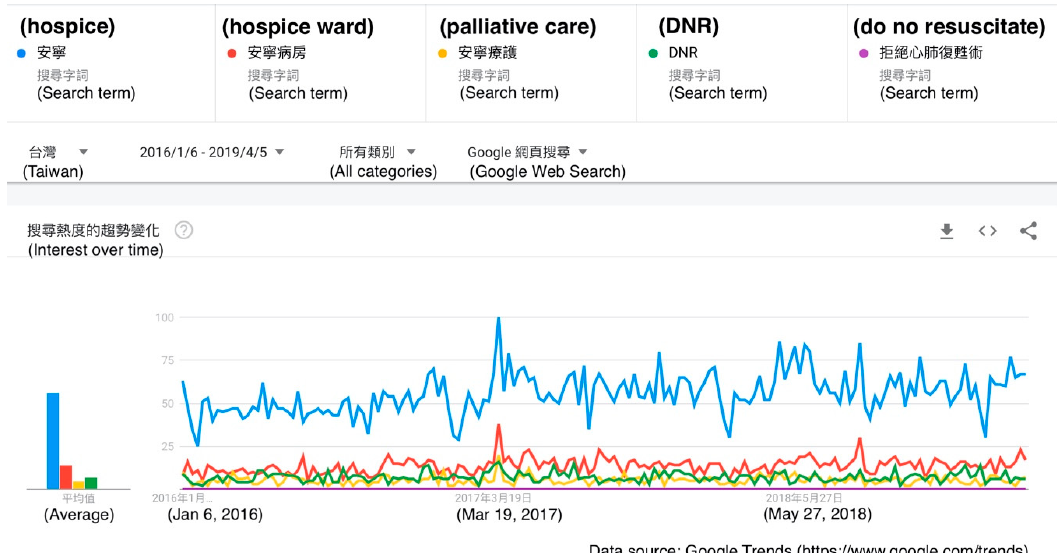
Figure 2. A Google Trends graph for the terms “advance care planning” (blue line), “advance decision” (red line), and “advance directive” (yellow line) in Taiwan from 6 January 2016 to 5 April 2019.